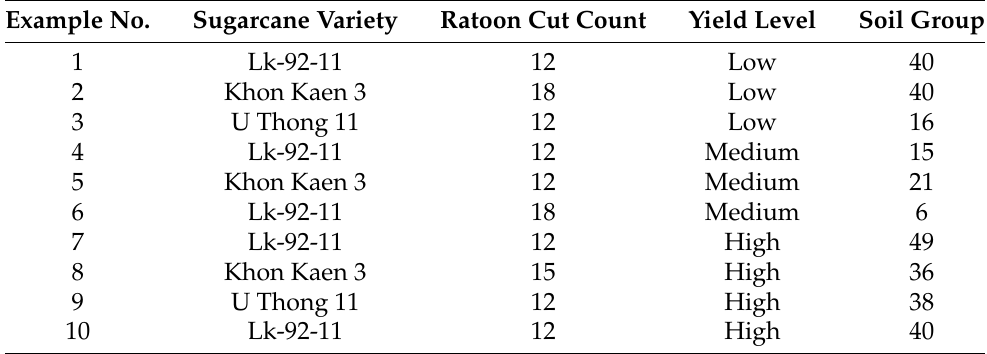
Table 1. Ten examples of field profiles.